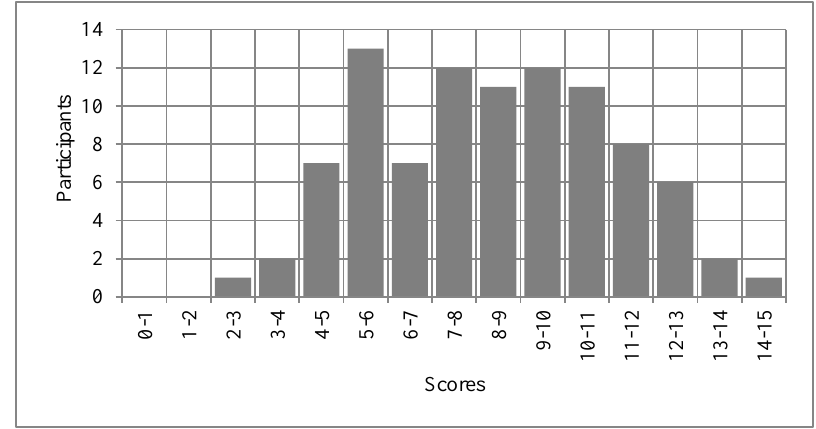
Fig. 1. Testing results on the topic "Magnetic Field in a Vacuum" with the optimal ratio of the questions complexity and the time for solving tasks.